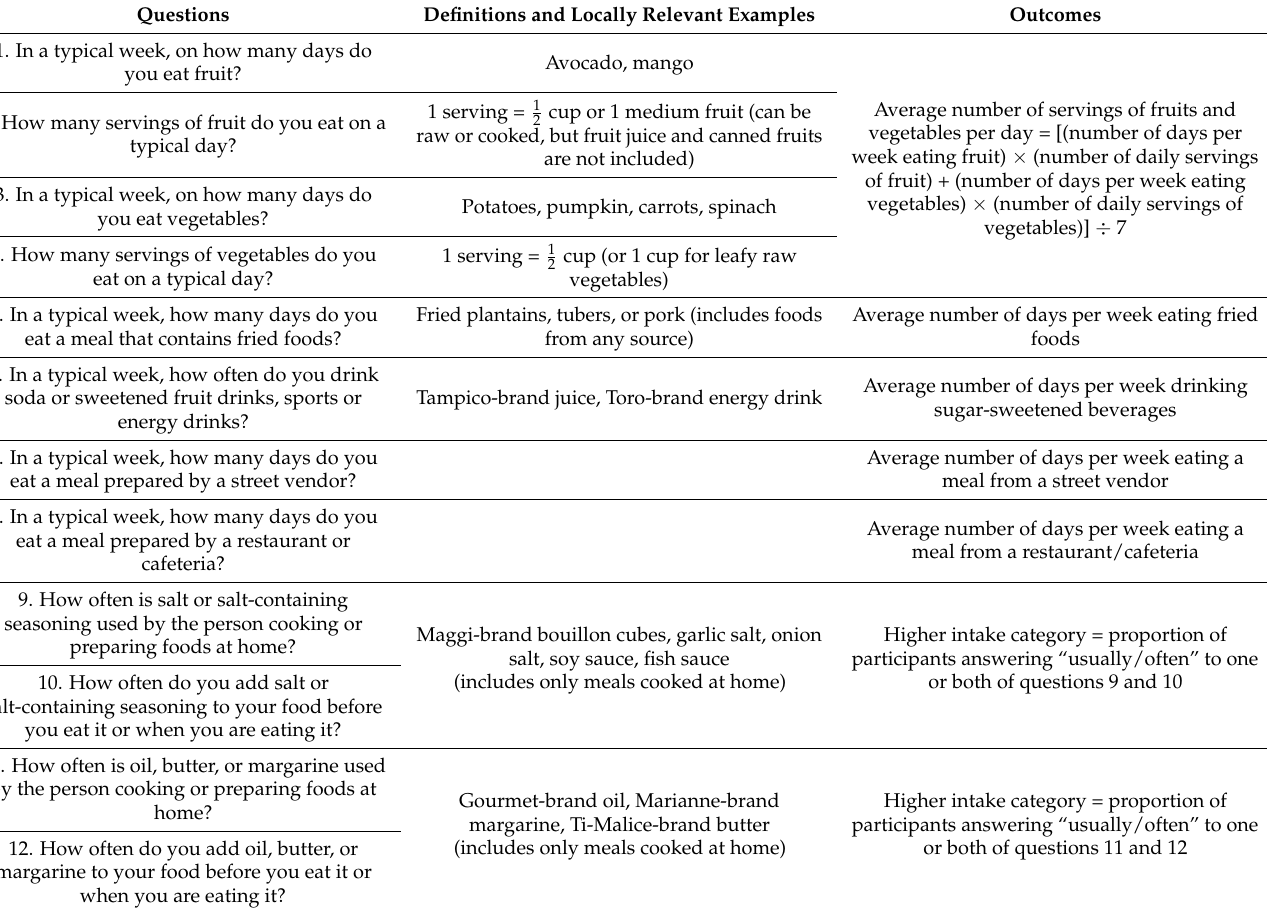
Table 1. Dietary questions from Haiti CVD Cohort study